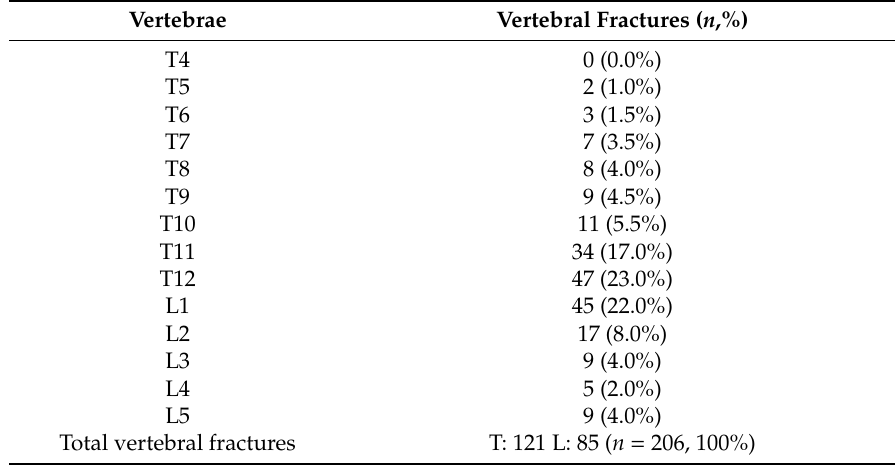
Table 2. Location of vertebral